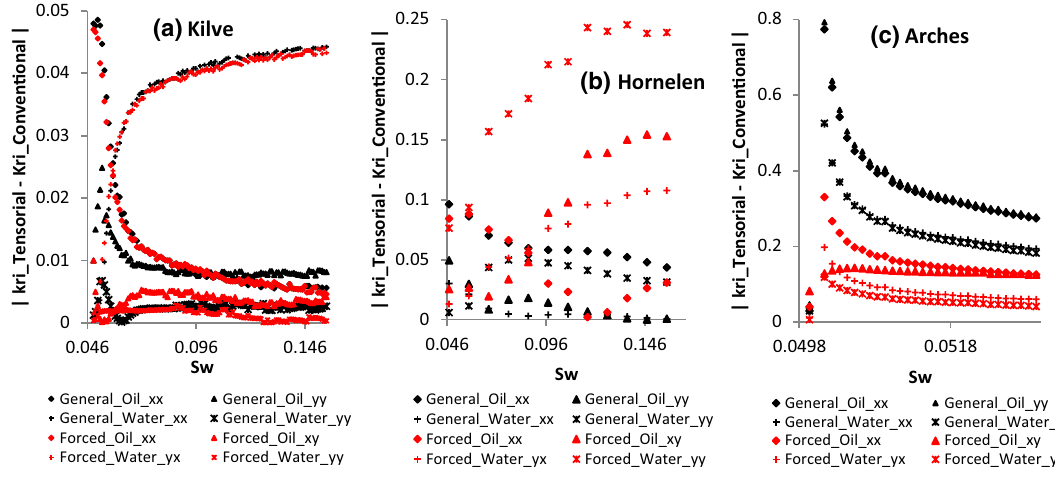
Fig. 8 Difference between the diagonal components of relative permeability tensor and the one the relative permeability obtained using conven- tional